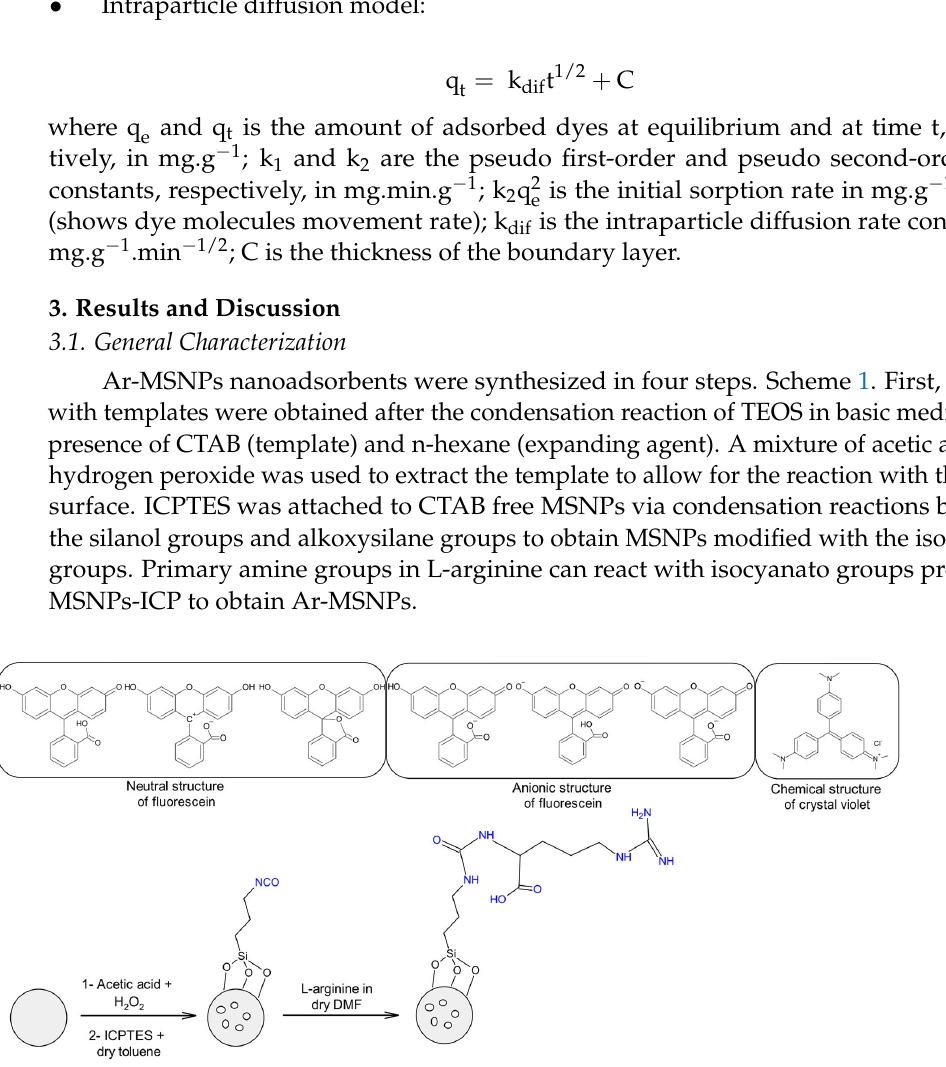
Scheme 1. Schematic representation: ( A ) the chemical structure of fluorescein and crystal violet